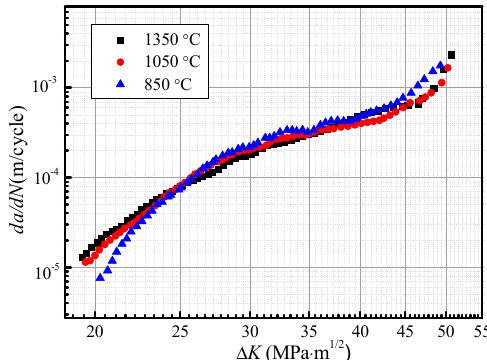
Figure 5. Fatigue life at different peak temperatures.